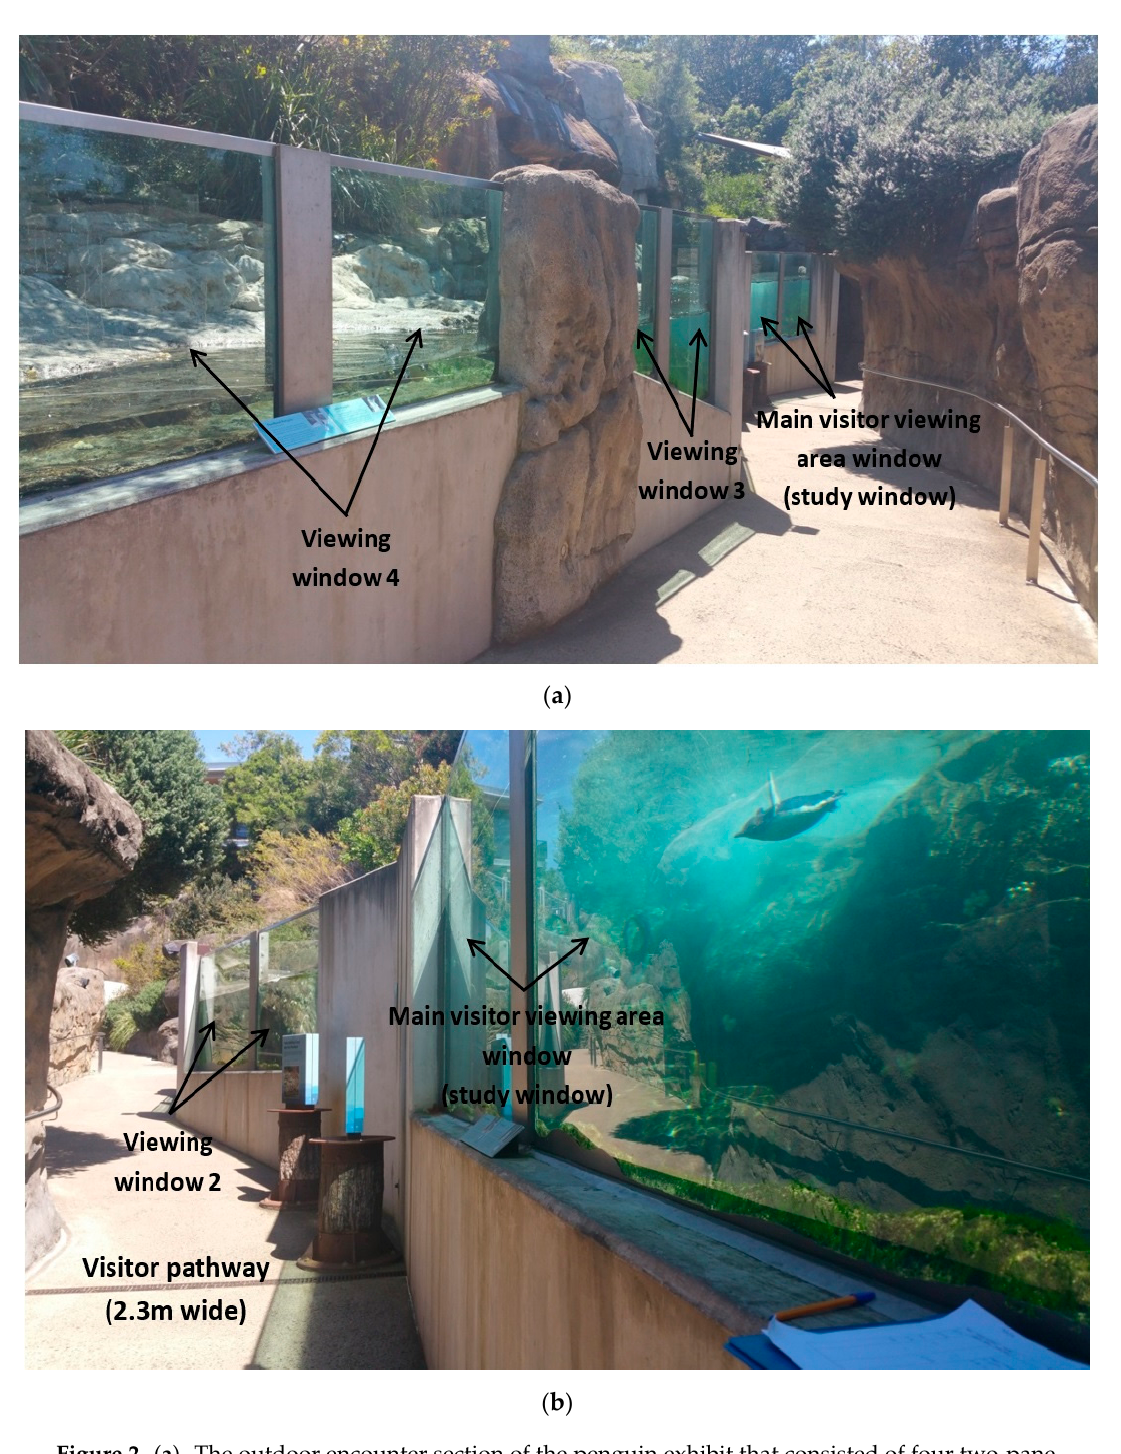
Figure 2. ( a ) . The outdoor encounter section of the penguin exhibit that consisted of four two-pane glass visitor viewing area windows (respectively labelled Main visitor viewing area window and Viewing window 2, 3 and 4) and a visitor pathway that slopes down to an underground viewing area of the main breeding group of penguins. ( b ) . The main visitor viewing area window and Viewing window 2 of the encounter section of the penguin exhibit where the main visitor viewing area window was our study window.